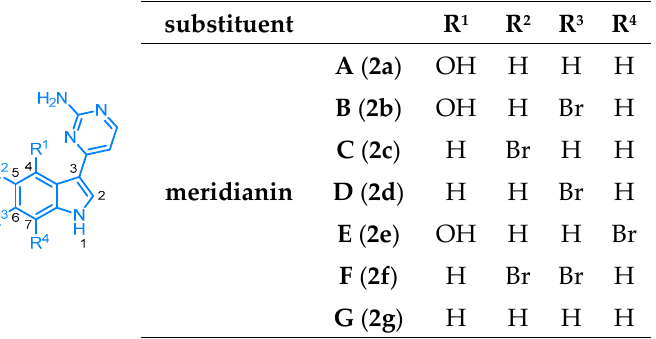
Figure 2. Meridianins 2 isolated from the tunicate Aplidium meridianum [9,10].